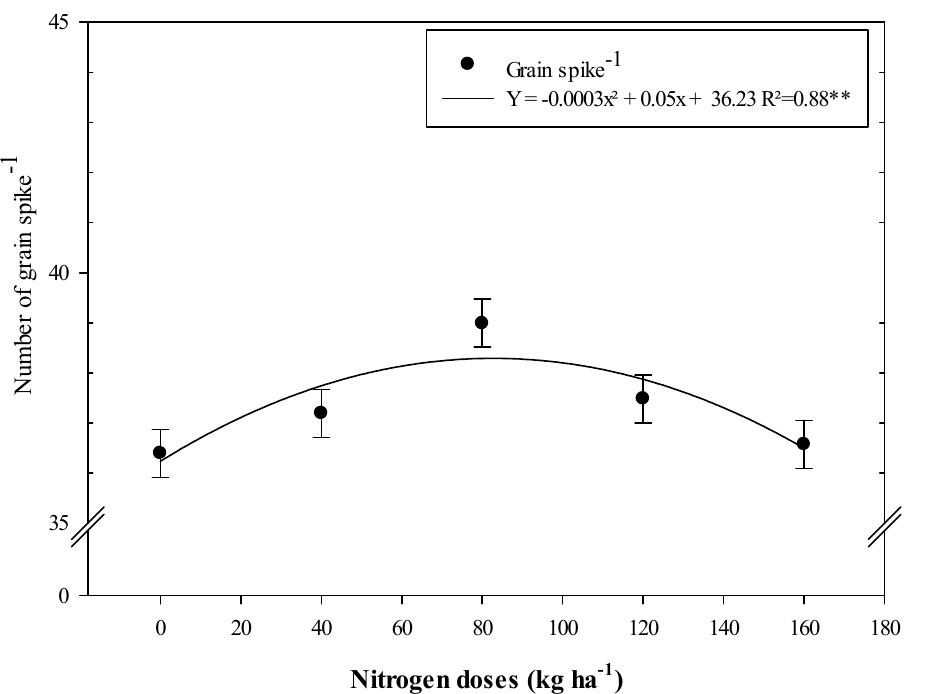
Figure 3. Number of grains spike − 1 of wheat as a function of N doses in the 2016 cropping season. Error bars indicate standard deviation of the means ( n = 4 replications). **: means it is statistically significant by Tukey's test at probability p ≤ 0.01.